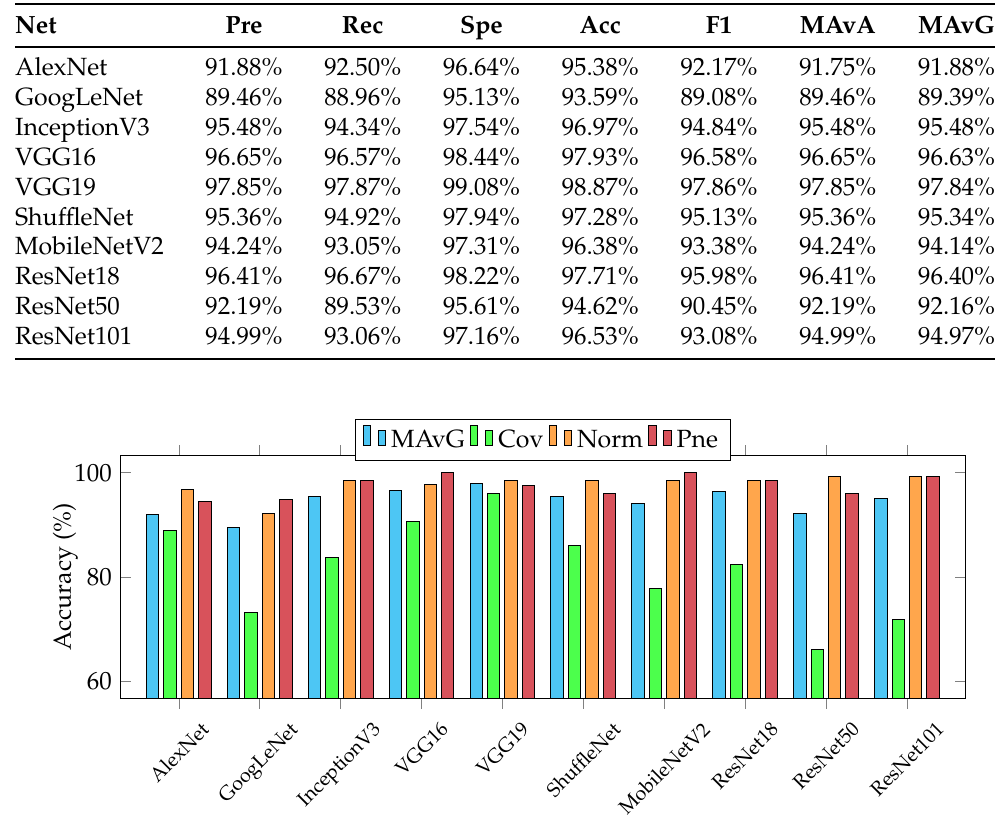
Table 2. Macro-average performance for testing on COVIDx CT-2A.